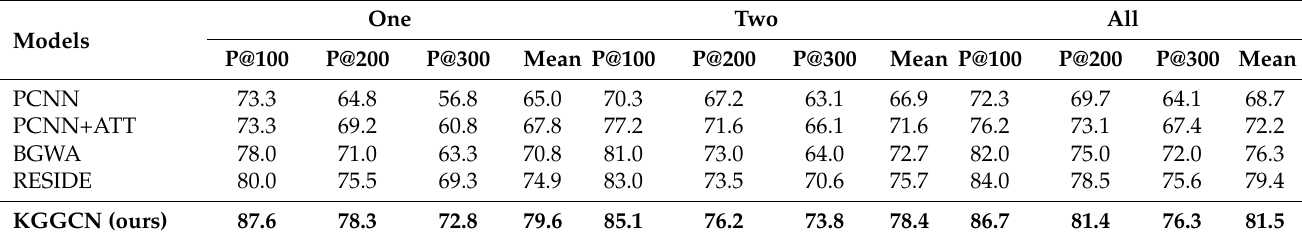
Table 3. Performances comparison of KGGCN with neural-based baseline models in terms of P@N using different number of sentences in bags on NYT-FB dataset. One, two, All mean the number of sentences randomly selected from a instance bag.